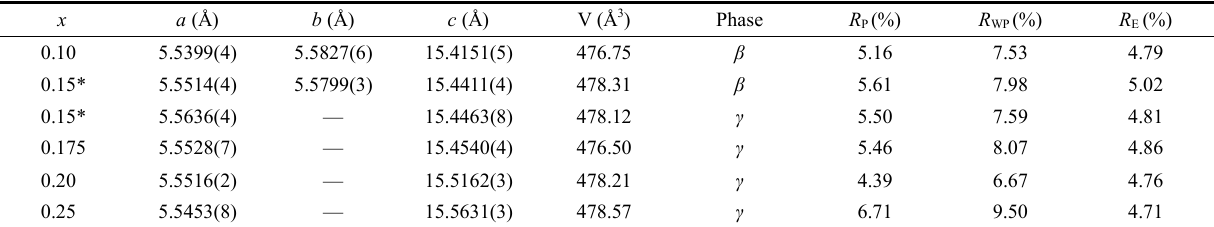
Table 2 Phase and lattice parameters (Rietveld refined) of the Bi 2 V 1– x Al x /2 Ti x /2 O 5.5– δ (0.10 ≤ x ≤ 0.250) compounds